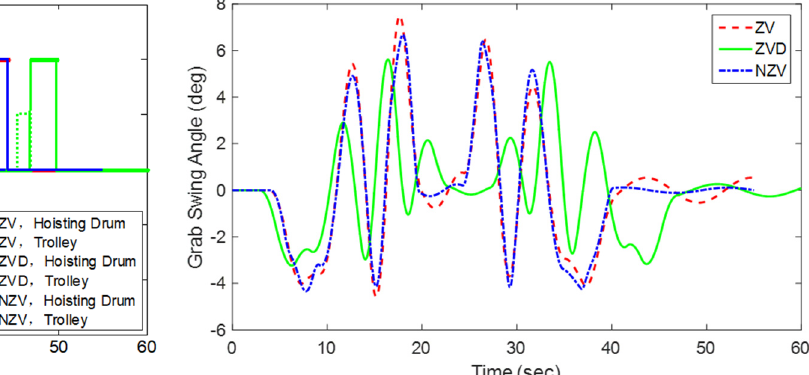
Fig. 3. Command angular acceleration curves of the hoisting drum and the command acceleration curves of the trolley under the different control methods.